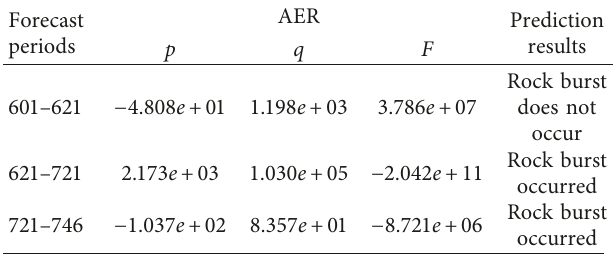
Table 3: Rock burst prediction of cubic red sandstone.